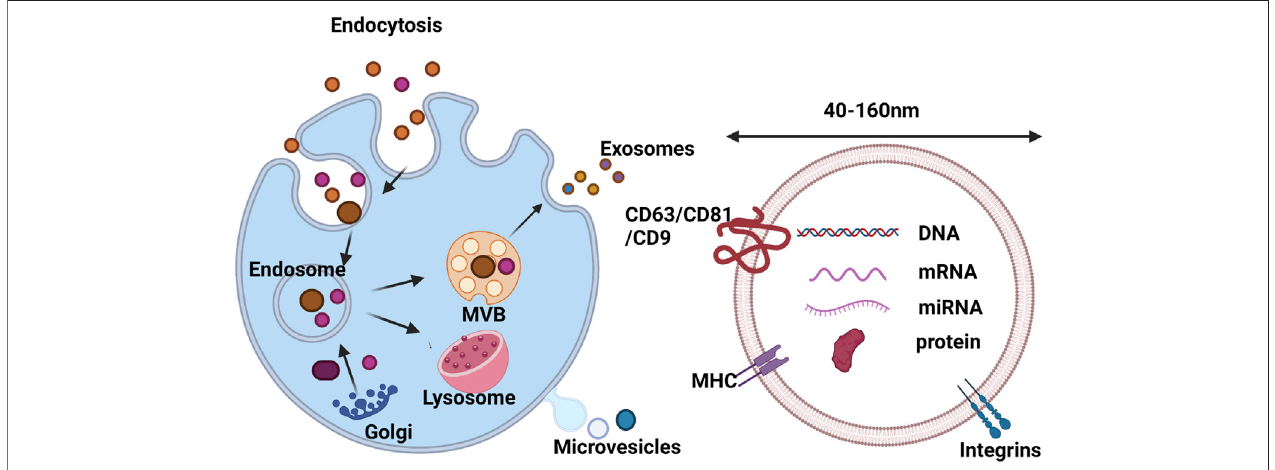
FIGURE 4 | Biogenesis and composition of exosomes. Exosome formation is initiated by invagination of the plasma membrane to form EEs, which fuse to form MVBs. Then, MVBs fuse with the plasma membrane to release exosomes into the extracellular matrix, or fuse with lysosomes for degradation. The composition of exosomes includes lipids, DNA, RNA and proteins (Huang et al., 2021). Copyright 2021, The Royal Society of